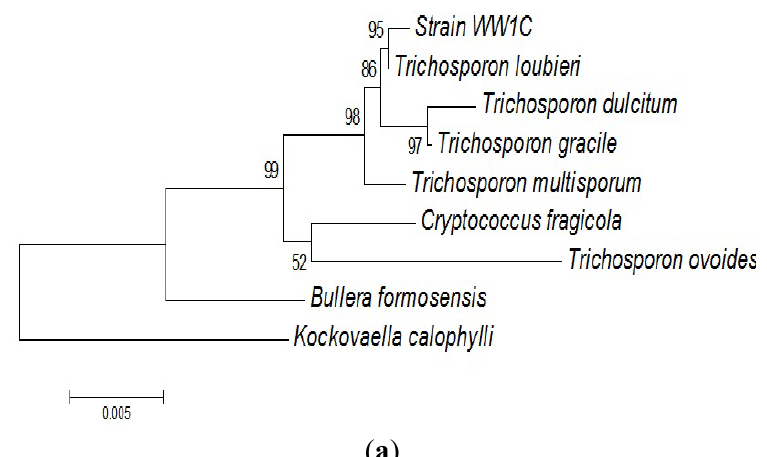
Figure 2. ( a ) 18S rDNA gene-based phylogenetic tree showing the phylogenetic position of strain WW1C generated using Neighbour-Joining algorithm. The horizontal bar at the bottom represents evolutionary distance as 0.005 changes per nucleotide position, determined by measuring the lengths of the horizontal lines connecting the species. The numbers (bootstrap values as percentages of 1,000 replications) provide support for the robustness of the adjacent nodes. Kockovaella calophylli was used as an outgroup; ( b ) ITS region-based phylogenetic tree showing the phylogenetic position of strain WW1C generated using Neighbour-Joining algorithm. The horizontal bar at the bottom represents evolutionary distance as 0.01 changes per nucleotide position, determined by measuring the lengths of the horizontal lines connecting the species. The numbers (bootstrap values as percentages of 1,000 replications) provide support for the robustness of the adjacent nodes. Cryptococcus laurentii and Cryptococcus curvatus were used as an